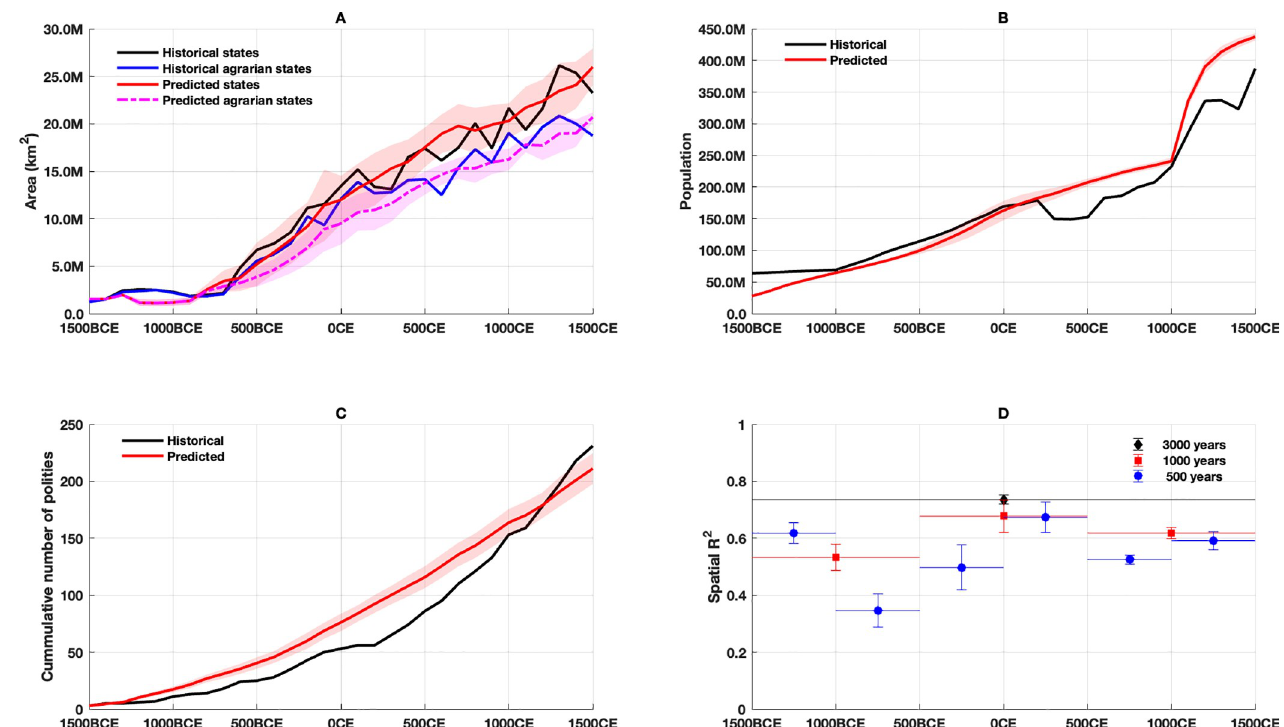
Fig 4. Overall polity statistics. Predictions for the Old World based on 32 trials (polities � 10 regions). A : Predicted mean and standard deviation of total area under all large-scale polities (red) and agrarian states (magenta) compared with historical values per century from [16] (black and blue, respectively). B : Predicted mean and standard deviation of total population (red) compared with historical values every 20 years from KK10 (black). C : Predicted mean and standard deviation of cumulative (red) number of large-scale polities surviving 50 years compared with historical values (black) from [16]. D : Mean and standard deviation of spatial R 2 metrics for 500 (blue), 1000 (red) and 3000 (black) year intervals.